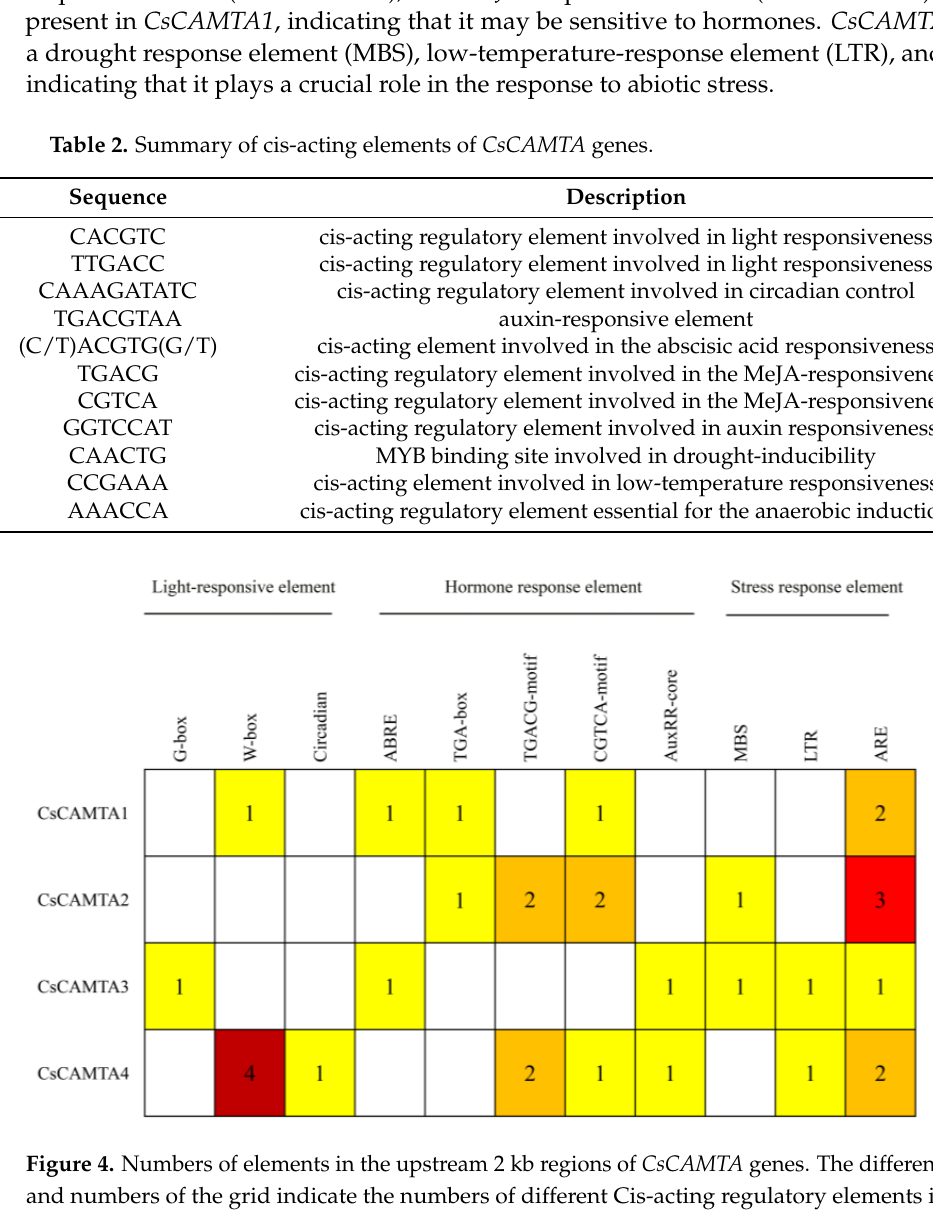
Table 2. Summary of cis-acting elements of CsCAMTA genes.